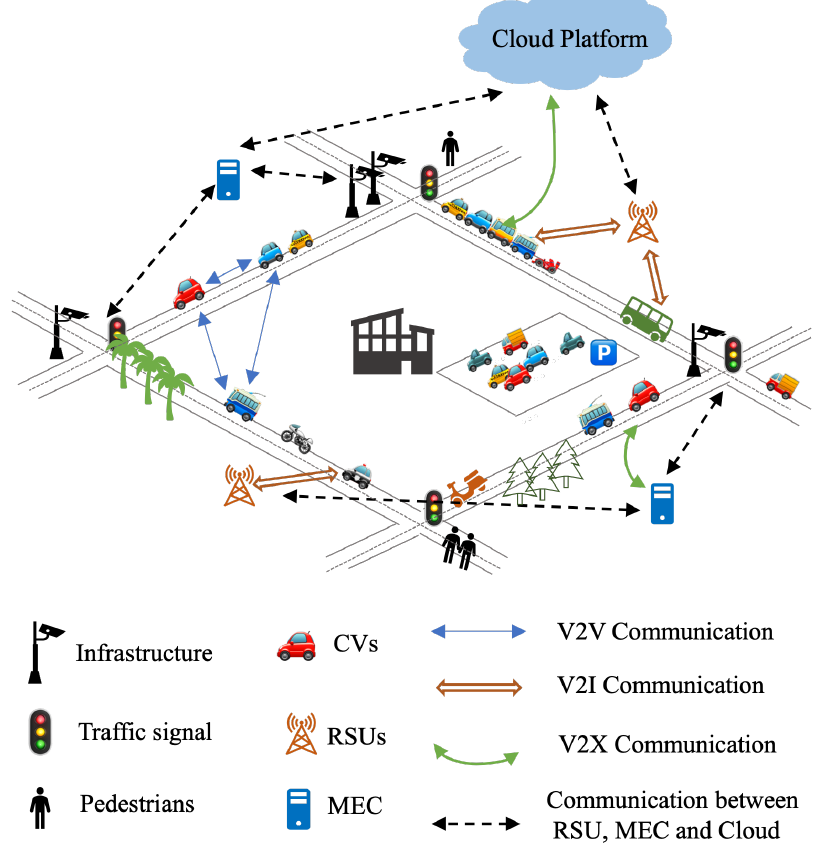
Figure 2. One scenario of Internet of